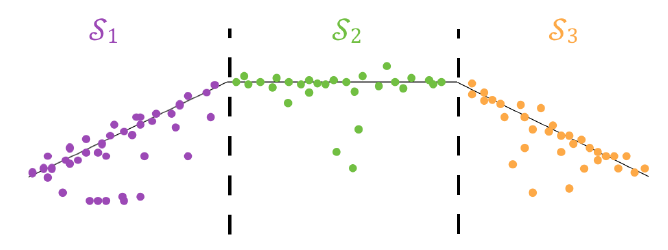
Figure 9. Illustration of the point cloud subdivision for plane